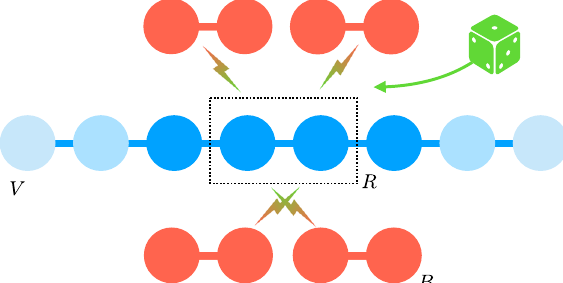
Fig. 1 Thermalization setting. Thermalization of a region R of an equilibrated lattice V via stochastic collisions with an external bath B (red).